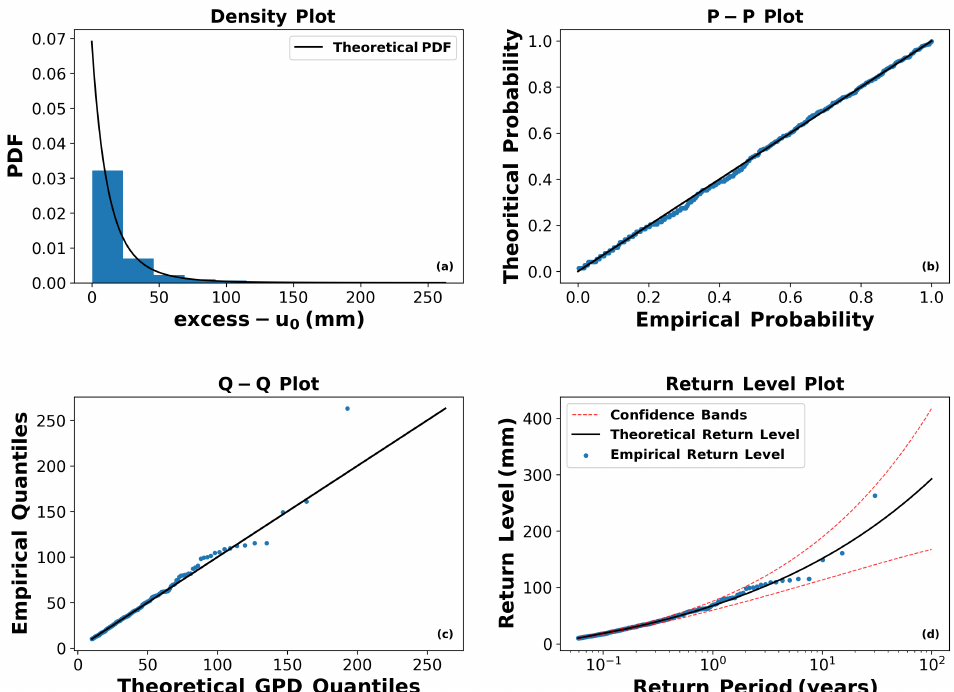
Figure 3. Diagnostic plot for the extreme rainfall data of the Crotone station: ( a ) probability density function, ( b ) probability plot, ( c ) quantile plot and ( d ) return level